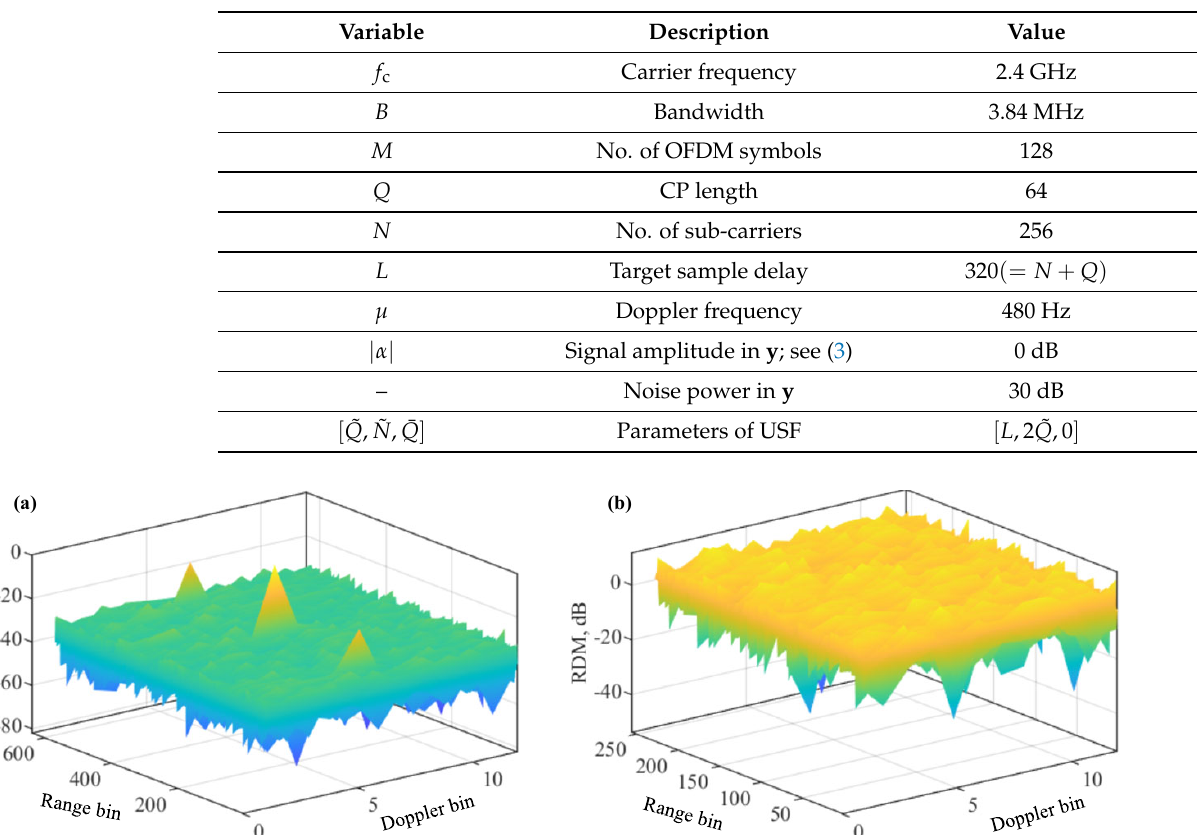
Table 1. Simulation P]parameters.